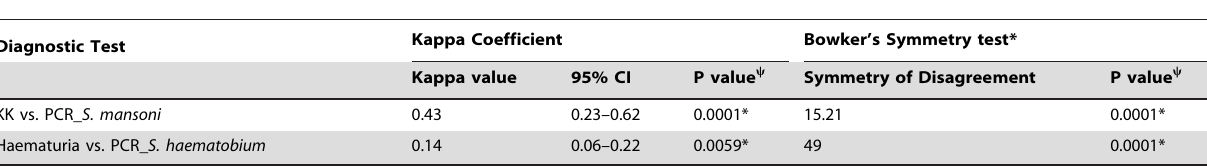
Table 3. Agreement statistics were calculated for KK, haematuria and